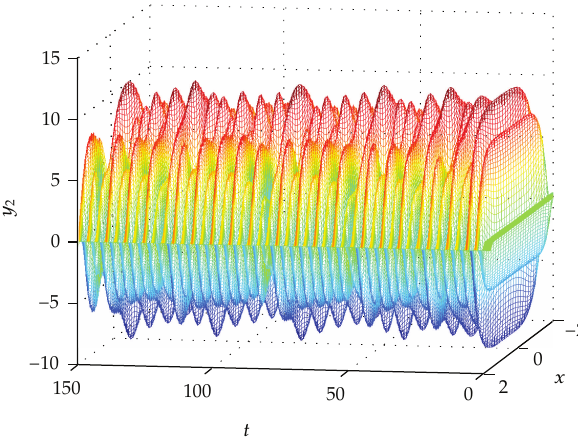
Figure 2: Chaotic behavior of the state y 2 (cid:6) t,x (cid:7) in system (cid:6) 4.1 (cid:7)